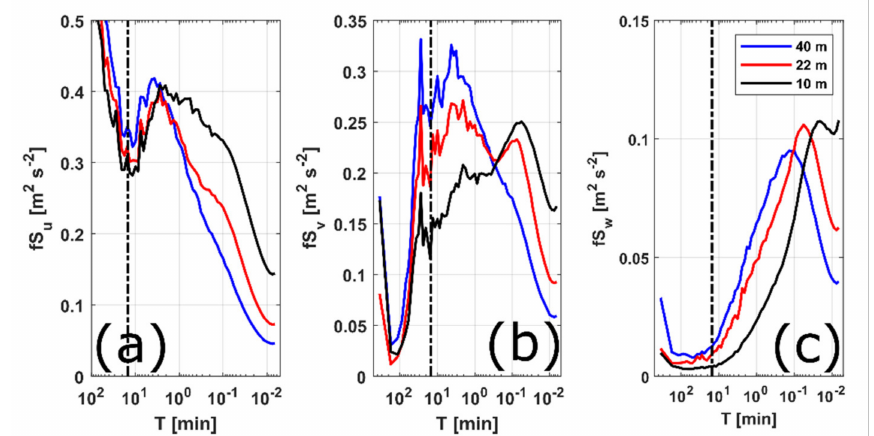
Figure 2. Composite frequency − weighted power spectral densities (medians shown) of the ( a ) longi- tudinal ( u ), ( b ) transversal ( v ) and ( c ) vertical ( w ) wind speed components for all three measurement heights of all bora episodes. Vertical dashed line marks 15 min